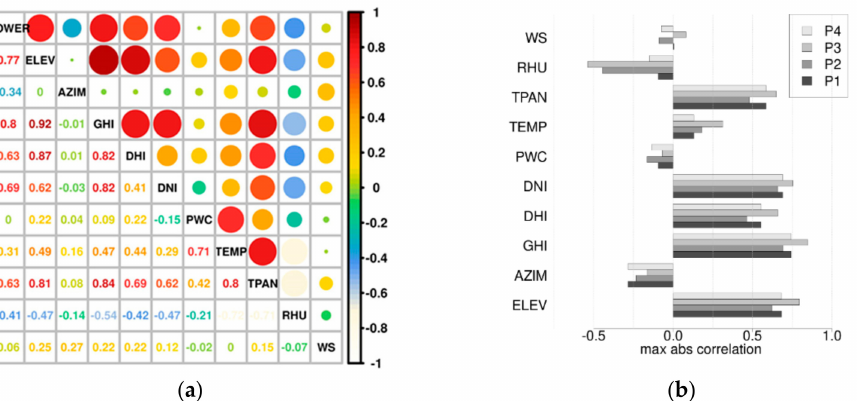
Figure 5. ( a ) Relationships between power production (POWER) and some weather variables provided by the NWP model WES , for the plant P1. ( b ) Maximum or minimum (over the four NWP models) correlation between measured production and weather variables in correspondence of the four